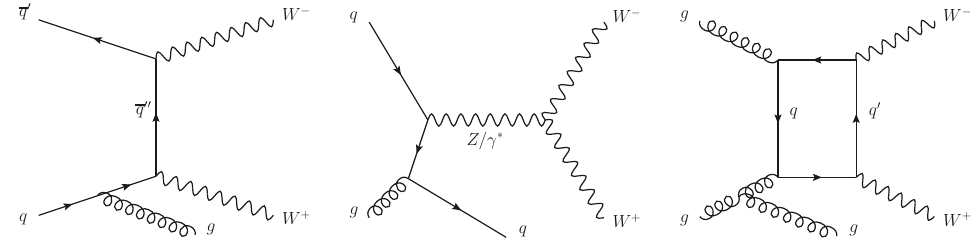
Figure 1 . Feynman diagrams for the production of a W + W − boson pair in association with a jet.